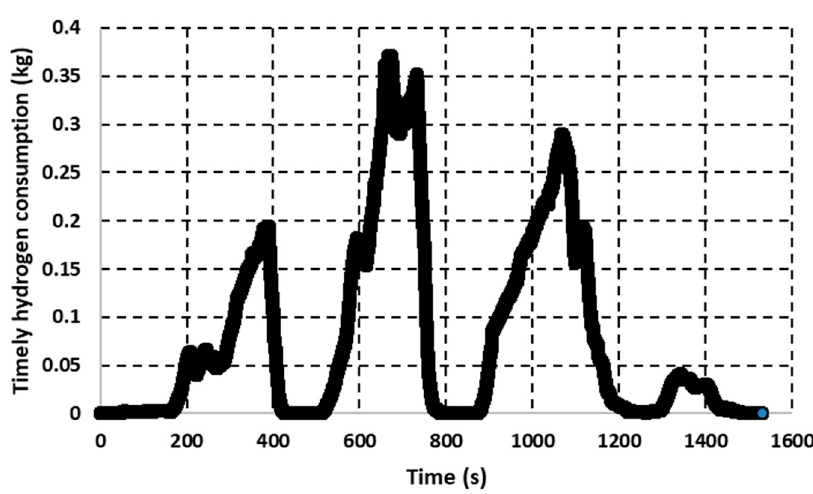
Figure 10. Timely hydrogen consumption.